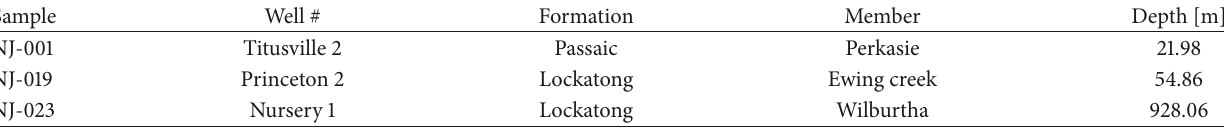
Table 1: Drilling sites, geological origin, and current depth of the sample